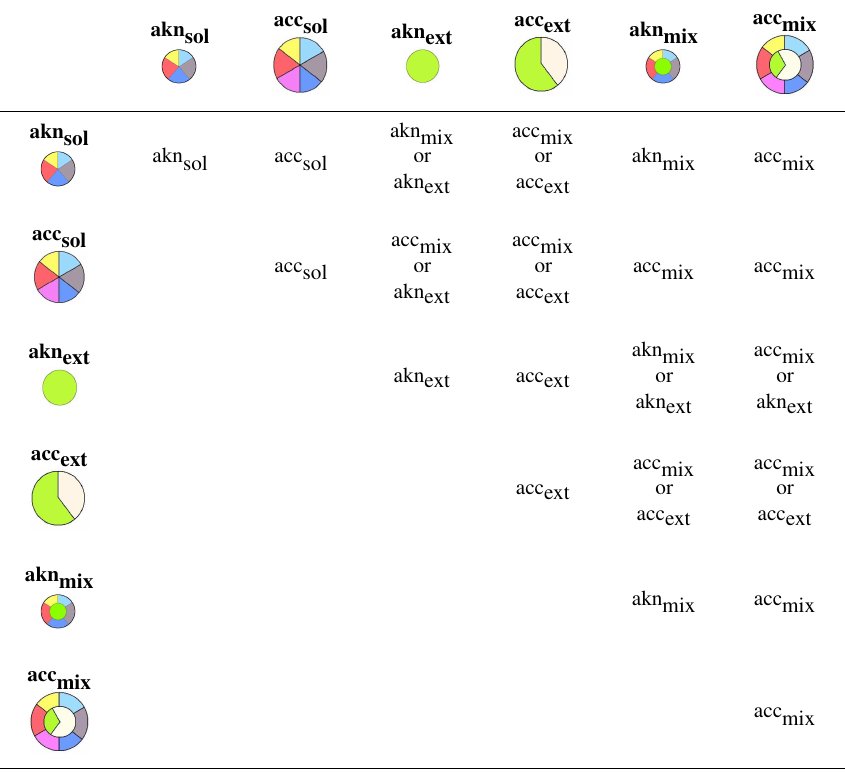
Table 3: Destination mode of each possible coagulation event in MADE-IN. The first row and the first column show the Table 3. Destination mode of each possible coagulation event in MADE-in. The first row and the first column show the coagulating modes. coagulating modes.